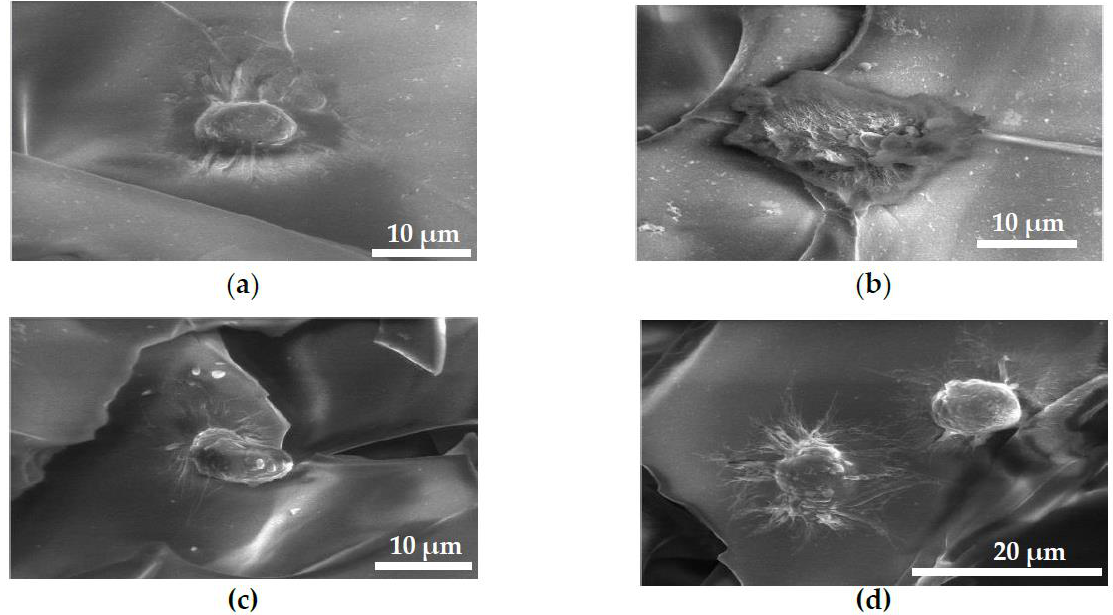
Figure 3. FESEM images of MG63 cells fixed on GTA crosslinked scaffolds, ( a – d ) CS, CS-GO2, CS-GO4 and CS-GO6, respectively.